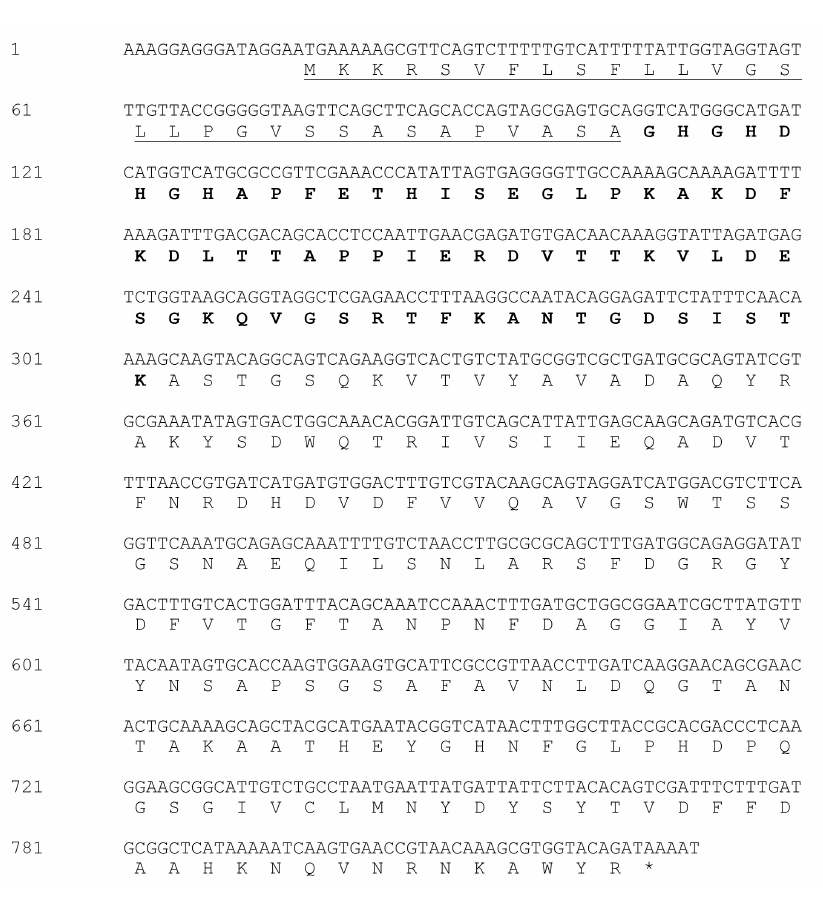
Figure 2. Nucleotide and amino acid sequence of PBN11-8. The full length of PBN11-8 cDNA was cloned using the degenerate primers approach. The amino acid sequence of PBN11-8 was deduced from the cDNA sequence. The asterisk indicates a stop codon. Signal peptide sequence is underlined, and the whole sequence of PBN11-8 amino acid residues is presented in bold.